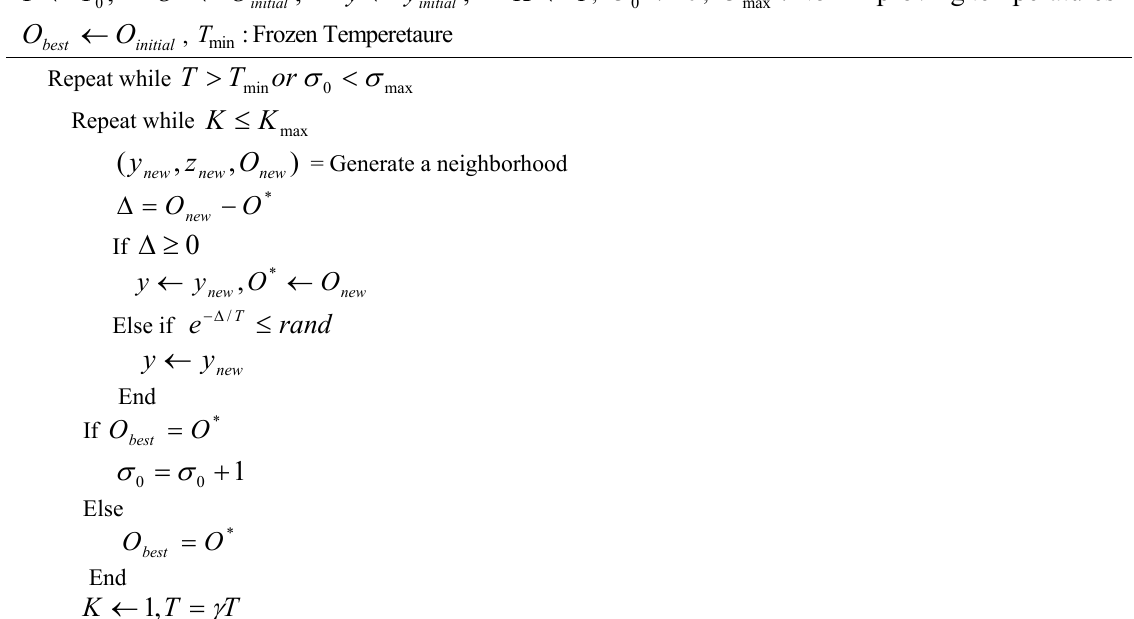
Fig. 1 Simulated annealing algorithm for solving